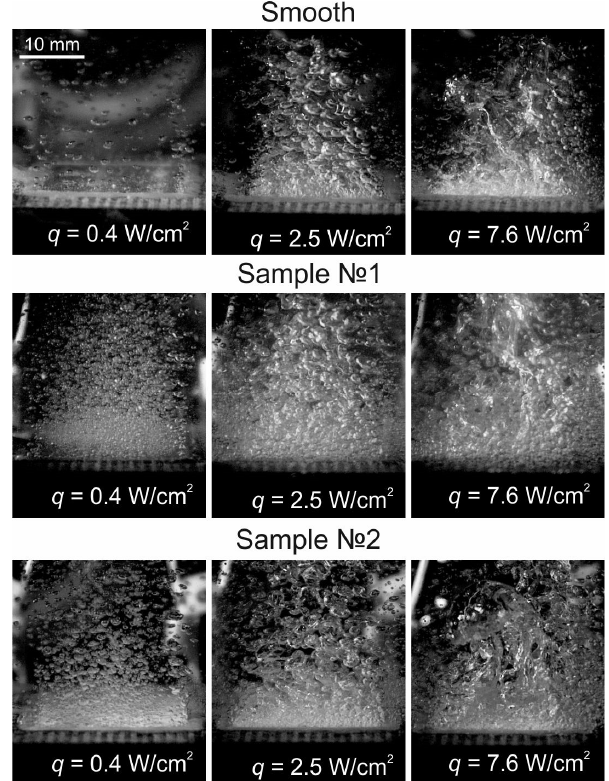
Figure 6. Boiling process at atmospheric pressure.